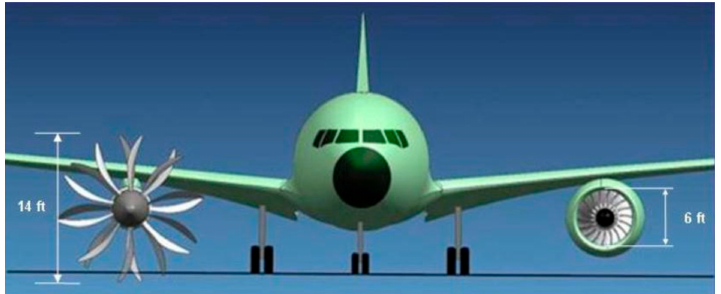
Figure 5. Large propeller installation issues for a low wing aircraft